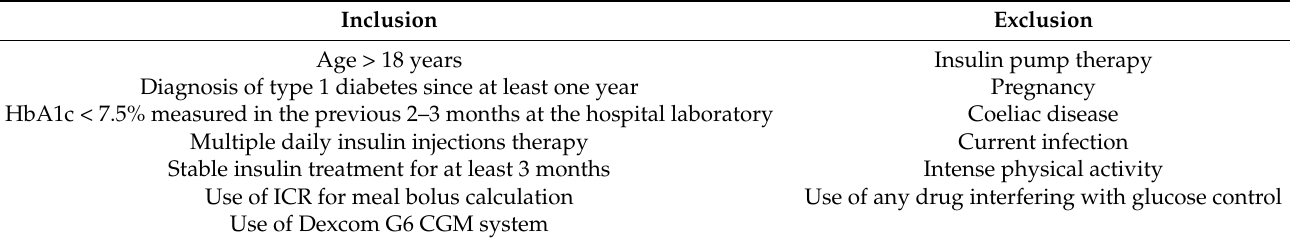
Table 1. Inclusion and exclusion